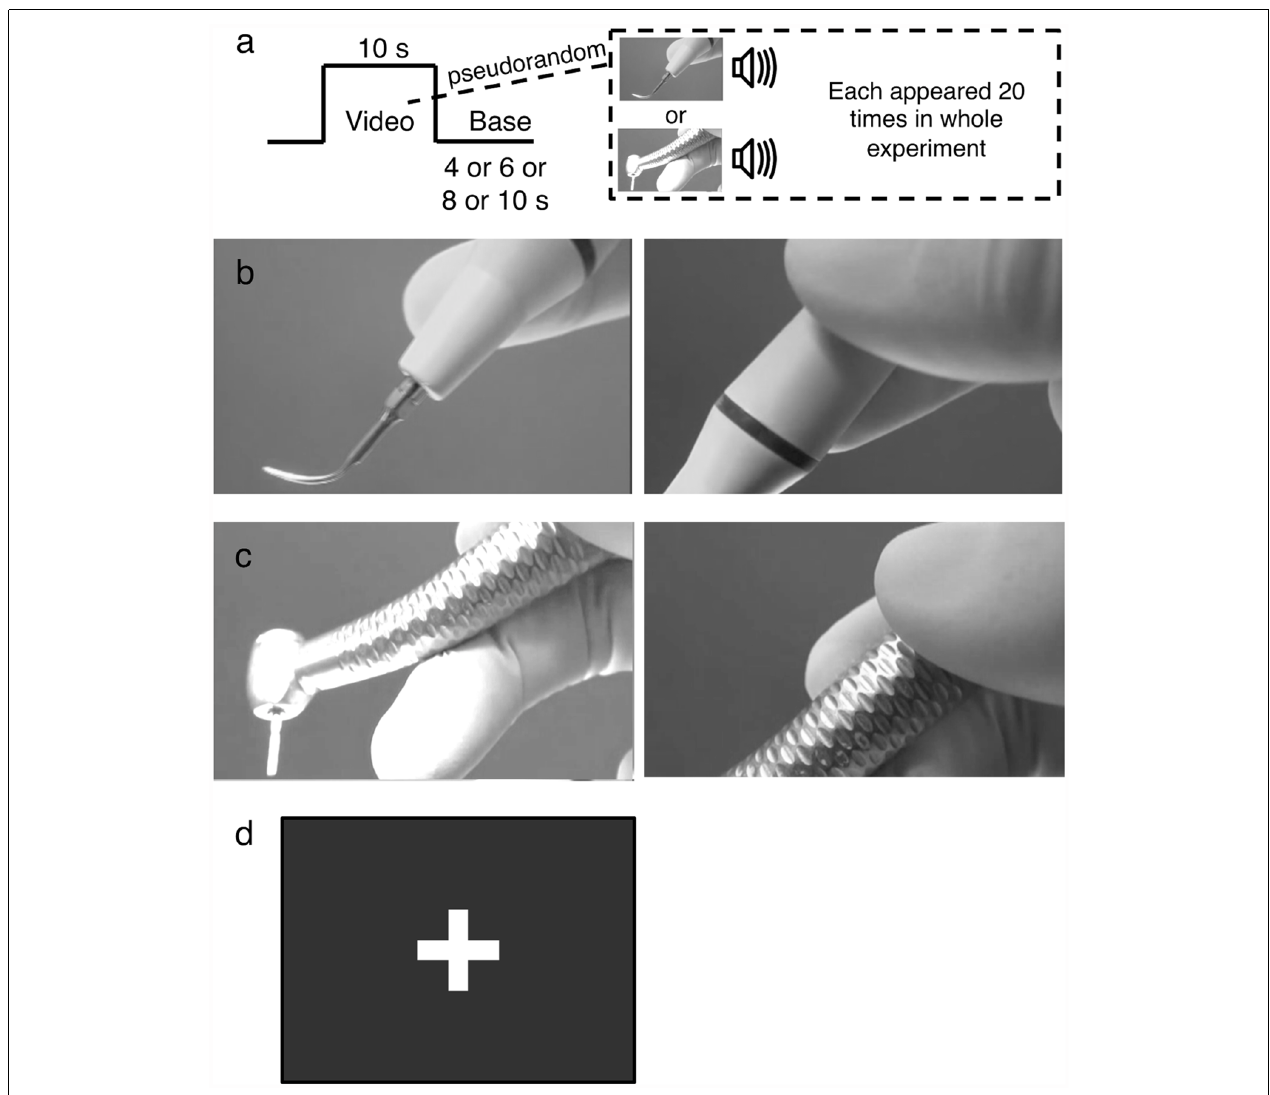
FIGURE 1 | The experimental design. (A) Example of the functional magentic resonance imaging (fMRI) block paradigm. Audiovisual footages of either a scaler or turbine were shown 20 times for 10 s each in a pseudorandomized order, alternating with a base image. The base image was pseudorandomly selected to be shown for 4, 6, 8, or 10 s. (B) The scaler video. It initially focused on the scaler tip (left panel) and zoomed in on the handle (right panel). (C) The turbine video. It initially focused on the drill attachment (left panel) and zoomed in on the handle (right panel). (D) The base. It was a still image of a white cross on a black background without any audio signal